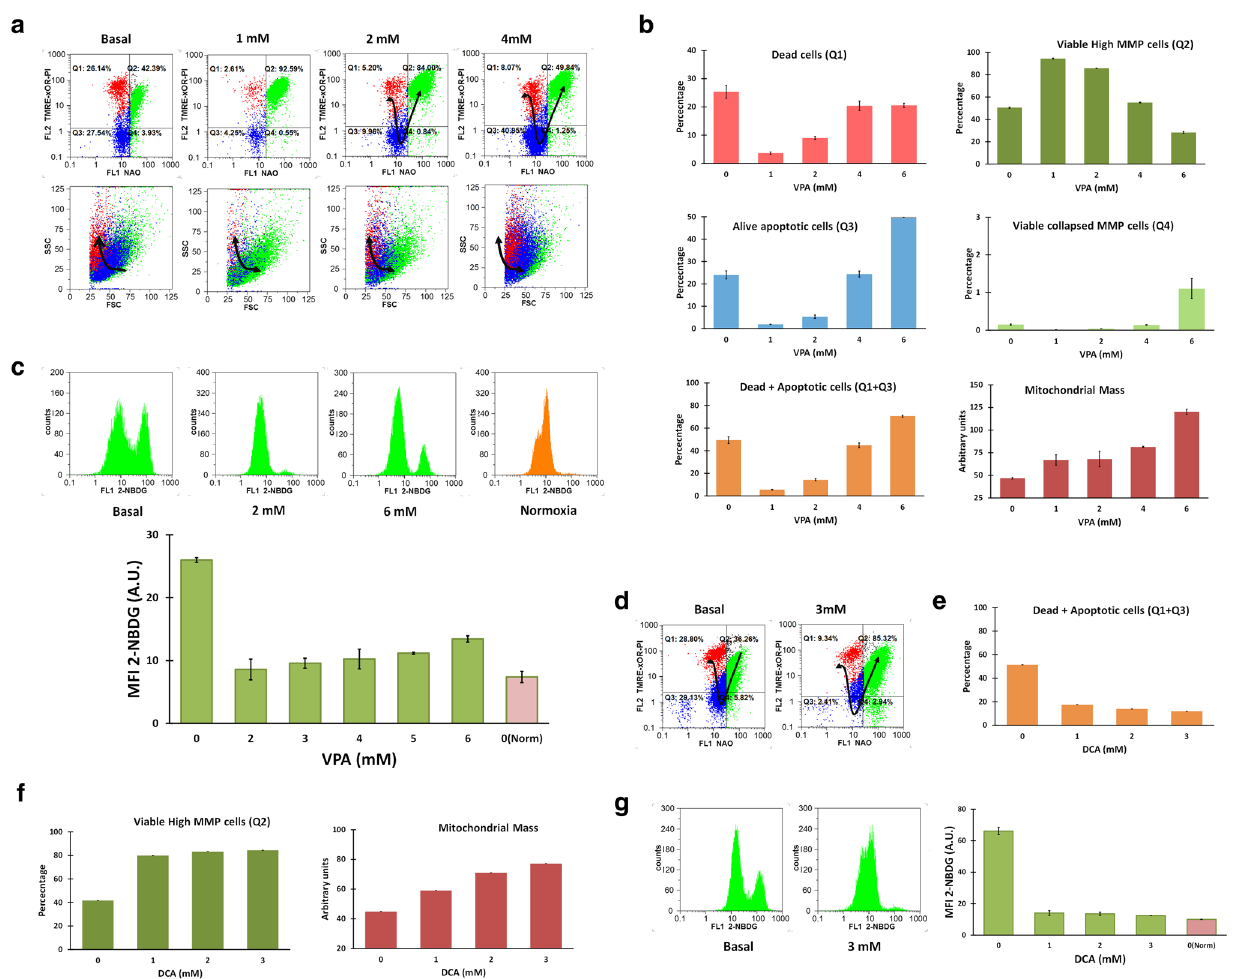
Fig. 5 VPA and DCA rescued cells from hypoxia-induced death at 72 h in BC-K562 cells. a Representative dot plots of VPA-treated cells under hypoxia. Untreated cells show about 60% dead and apoptotic cells (red and blue dots respectively), but were rescued at 1–2 mM VPA, achieving above 80% of live cells with rdCL and high MMP (green dots). b Bar graphs showing VPA pro-survival effect with decreased percentage of dead and apoptotic cells, increased MMP and increased MM in the VPA-rescued cells consistent with increased mitochondrial biogenesis. VPA at 4 mM and above became cytotoxic. c Four representative histograms of cells labelled with 2-NBDG, and a bar graph showing strong decrease in glucose uptake within 1–6 mM VPA. MFI: mean fluorescence intensity; A.U. arbitrary units. d Representative dot plots of DCA-treated cells under hypoxia showing a rescuing effect from hypoxia-induced cell death at 3 mM DCA. e Bar graphs showing a strong rescuing effect from hypoxia-induced cell death at 1–3 mM DCA from about 60% in untreated cells to less than 10% in DCA treated cells. f Representative histograms of cells labelled with 2-NBDG, and a bar graph showing strong decrease in glucose uptake within 1–3 mM DCA. MFI: mean fluorescence intensity; A.U. arbitrary